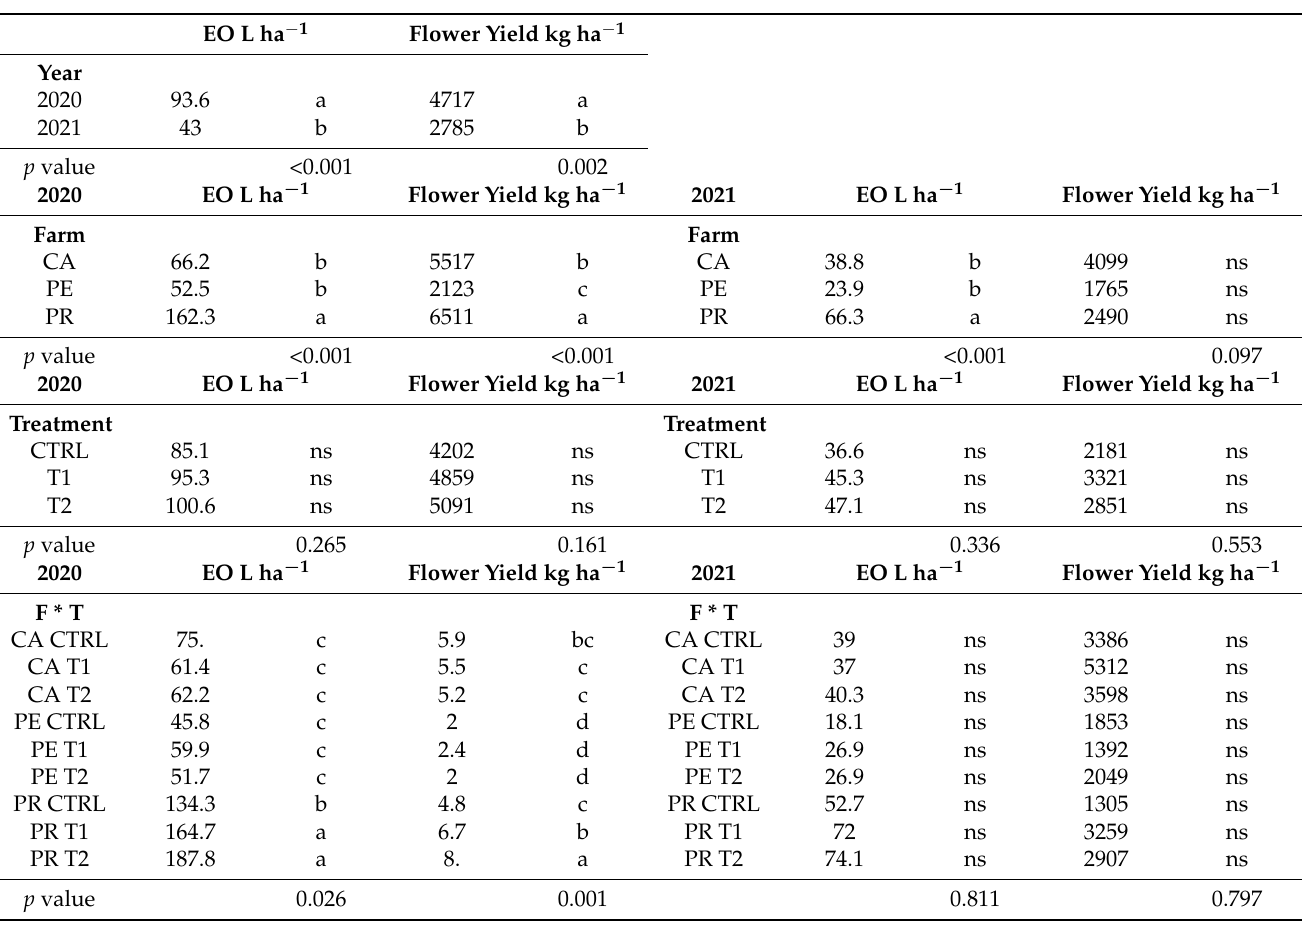
Table 3. Result of the ANOVA test performed on the agronomical parameters from 2019/2020 and 2020/2021. a–c means followed by different letters are statistically significant at p < 0.05; ns, not significant. F * T, farm * treatment